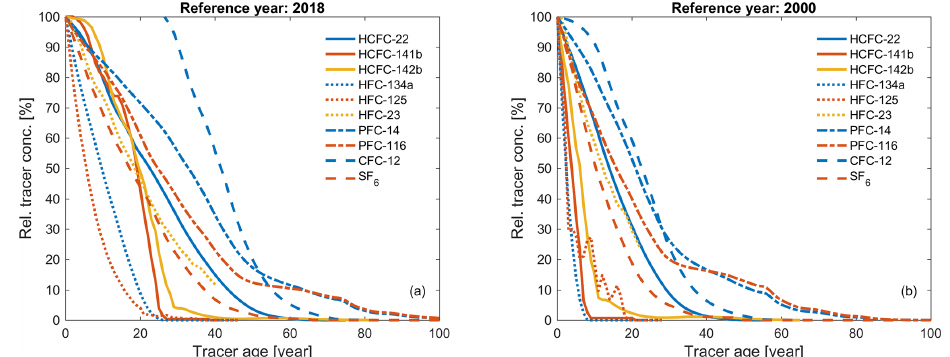
Figure 6. Relative tracer concentrations in percent (i.e., normalized to the contemporaneous atmospheric concentrations) and corresponding tracer age for HCFC-22, HCFC-141b, HCFC-142b, HFC-134a, HFC-125, HFC-23, PFC-14, PFC-116, CFC-12, and SF 6 in the Northern Hemisphere for two sampling years: (a) 2018 and (b) 2000.